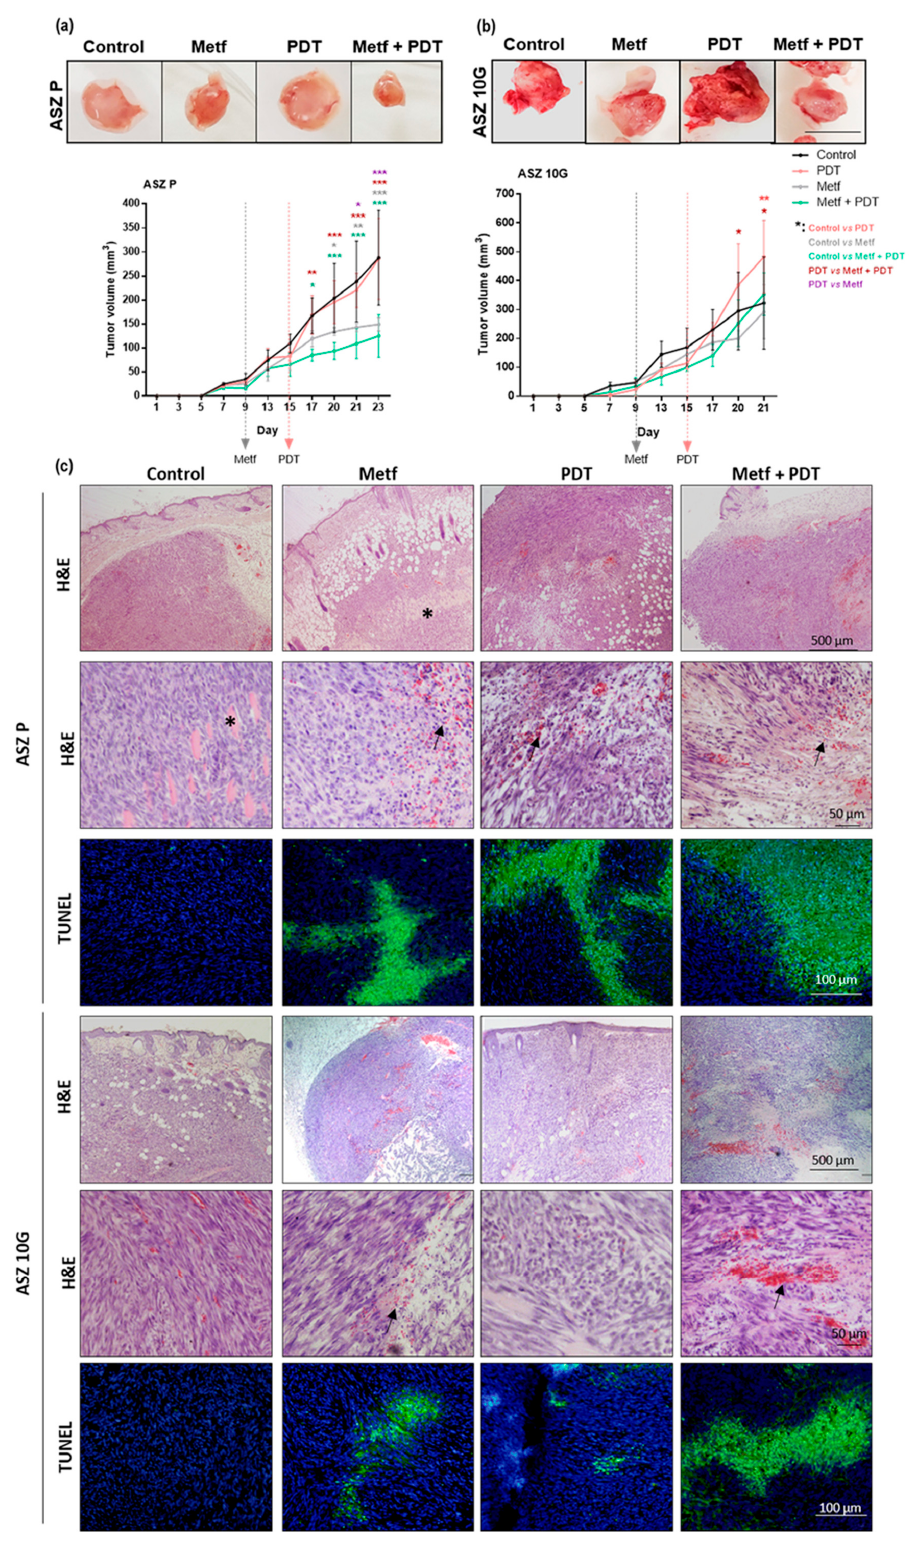
Figure 6. E ff ect of the treatments with Metf and / or PDT of ASZ tumors induced in mice: Photographs of the tumors at the time of sacrifice and the evolution of tumor volumes over time after the treatments in ( a ) P and ( b ) 10 G ASZ tumors. At day 9, when the tumors reached a volume of 50 mm 3 , they were treated with Metf (200 µ g / mL diluted in drinking water along the rest of the experiment). At day